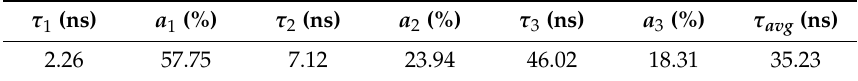
Table 3. Summarized PL lifetimes and their fractions in the CsPbBr 3 thin disk, calculated by the tri- exponential decay model.